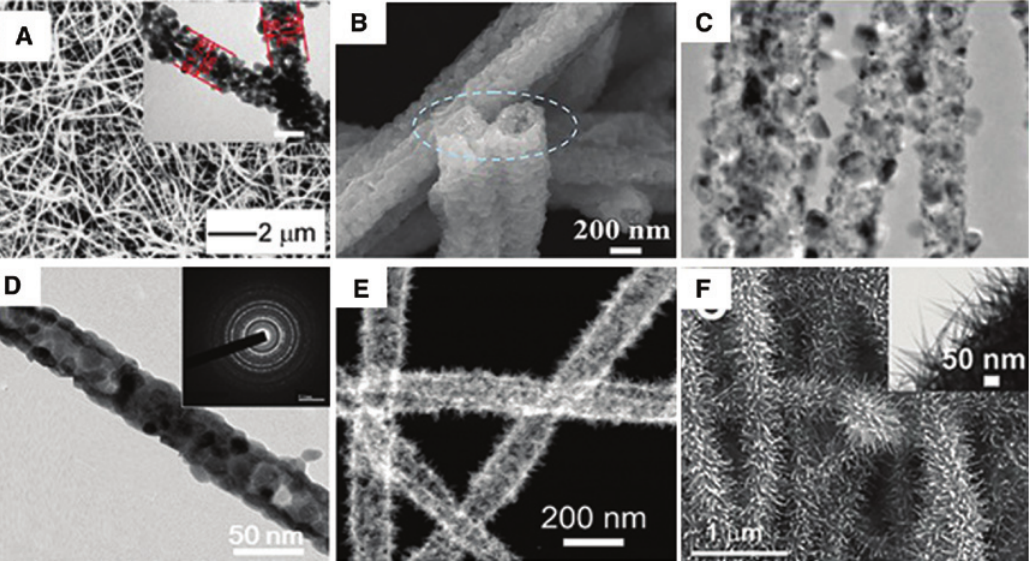
fibers for sensing hydro- 2 O nanofibers for sensing 2 3 nanoneedle/TiO nanofiber heterojunctions for sensing 3 2